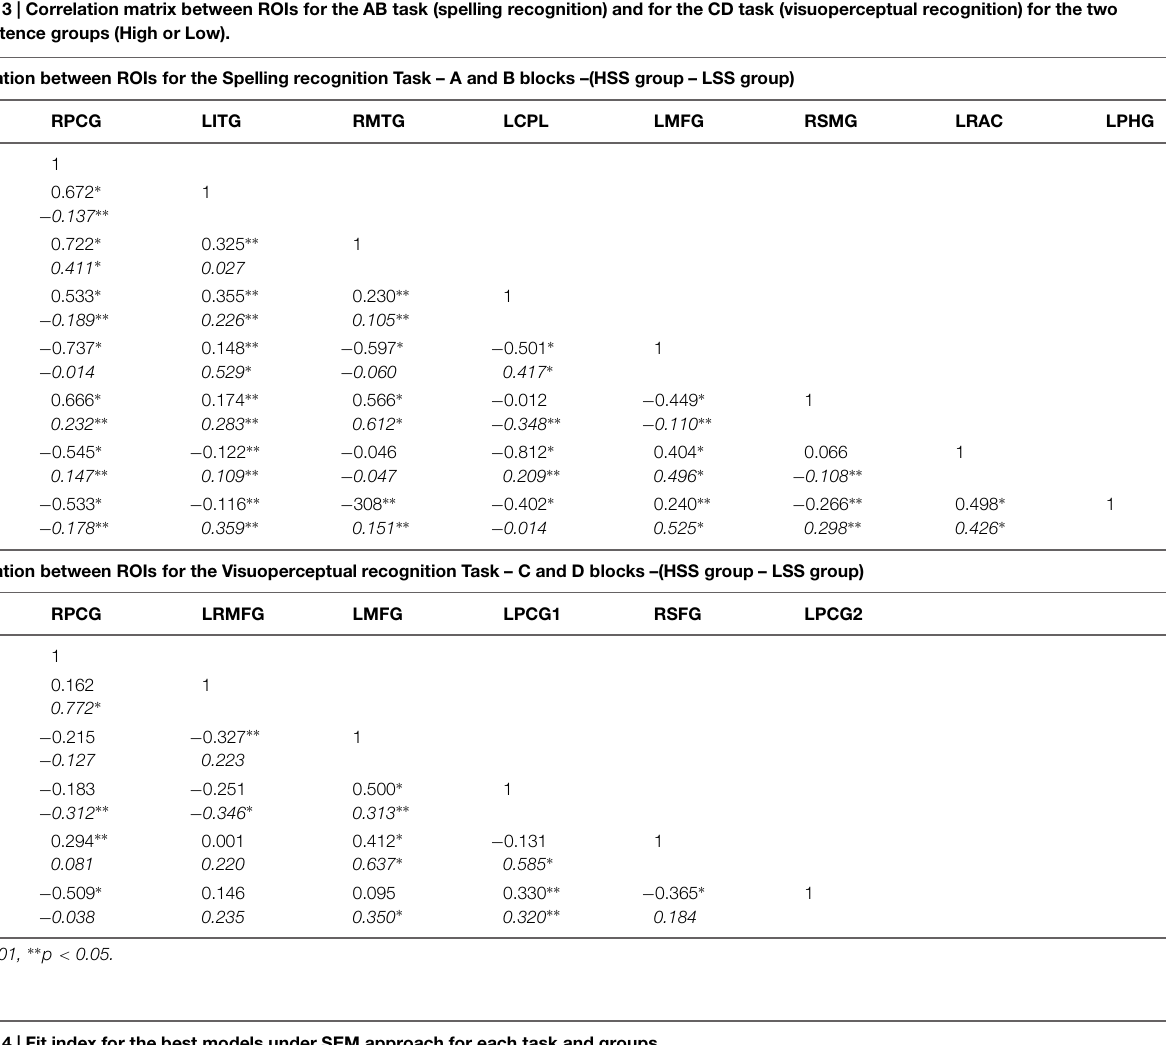
TABLE 4 | Fit index for the best models under SEM approach for each task and groups. Spelling recognition Task – A and B blocks